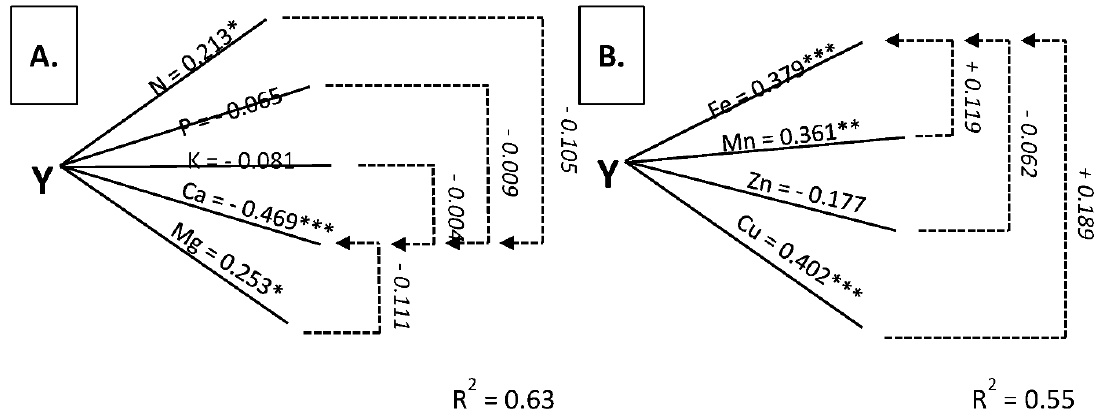
Figure 4. Path diagram of the impact of macronutrients ( A ) and micronutrients ( B ) contents in potato stolons + roots at the onset of tuberization on the marketable tuber yield. ***, **, * significant at p < 0.001; < 0.01; < 0.05, respectively.